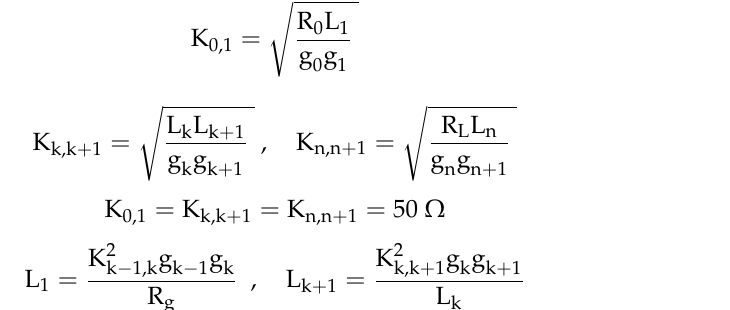
Table 1. Chebyshev coefficients of a 4th-order filter for a 0.01 dB ripple.